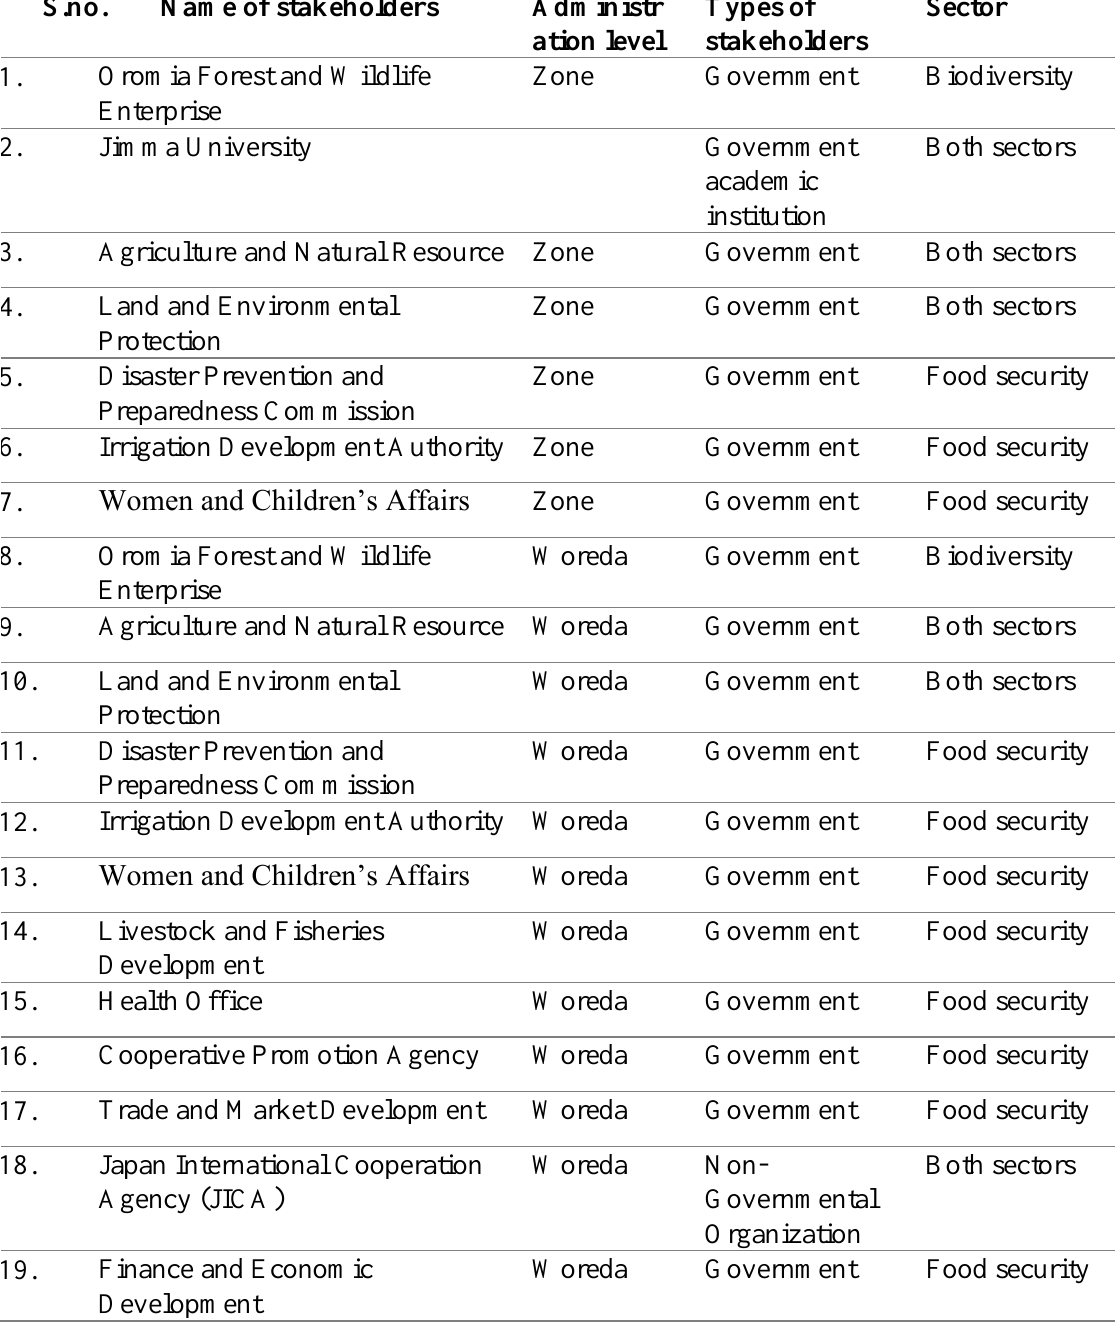
Table A1.1. List of stakeholders who participated in the scenario workshops. The table lists the names of stakeholder organizations that participated in the three rounds of workshops. With few exceptions, each stakeholder was represented by one senior staff member. Only few of these representatives were replaced across workshop rounds due to personnel